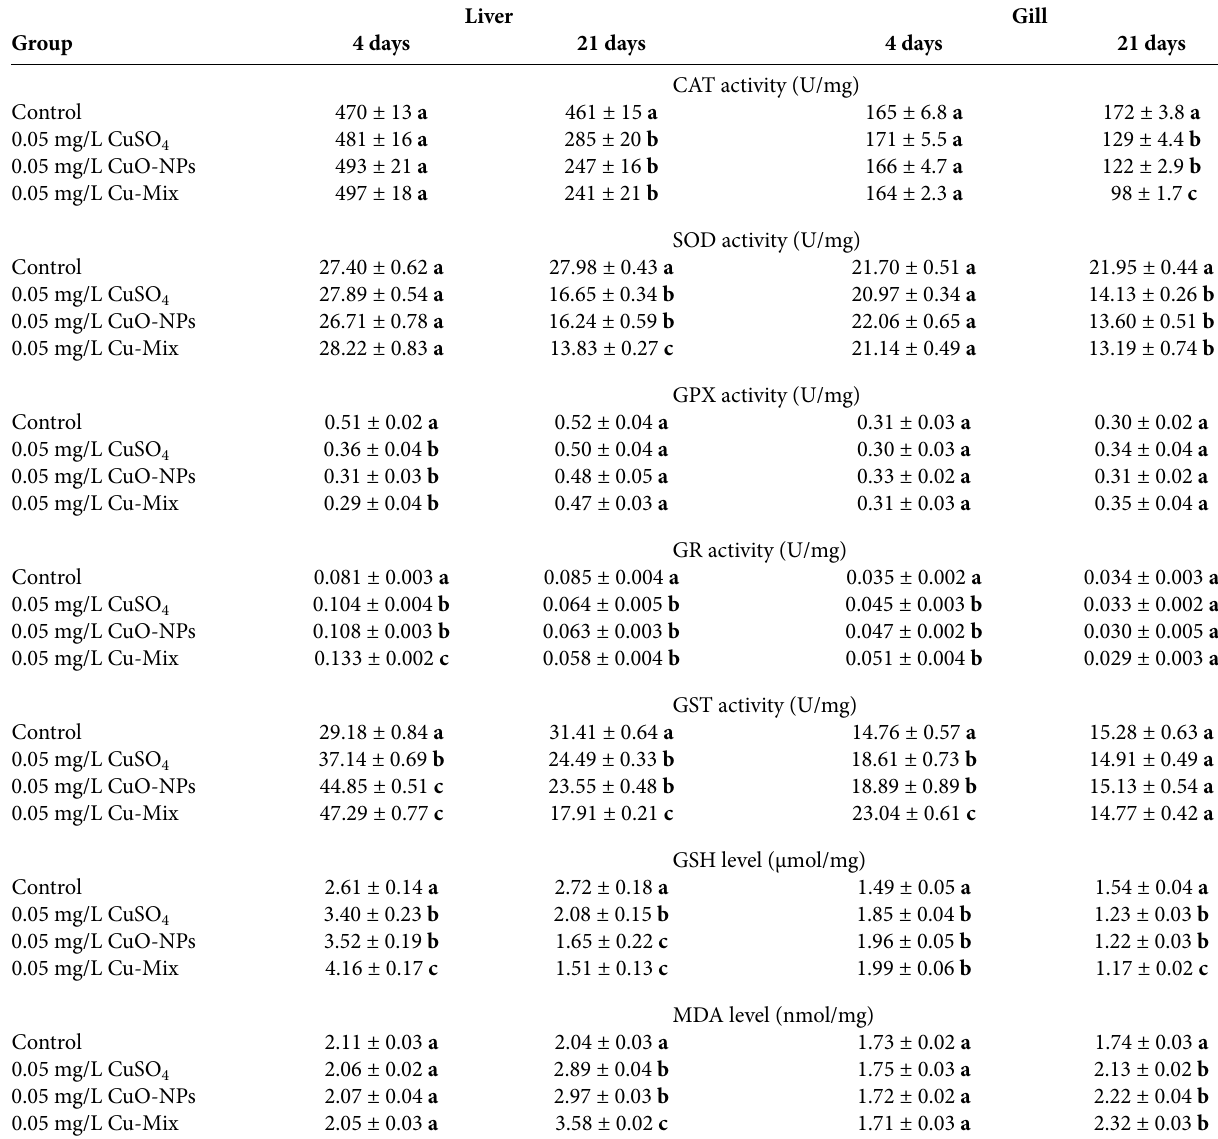
Table 3. Effects of individual and co-exposure of CuSO 4 and CuO-NPs on tissue oxidative stress parameters of O. niloticus